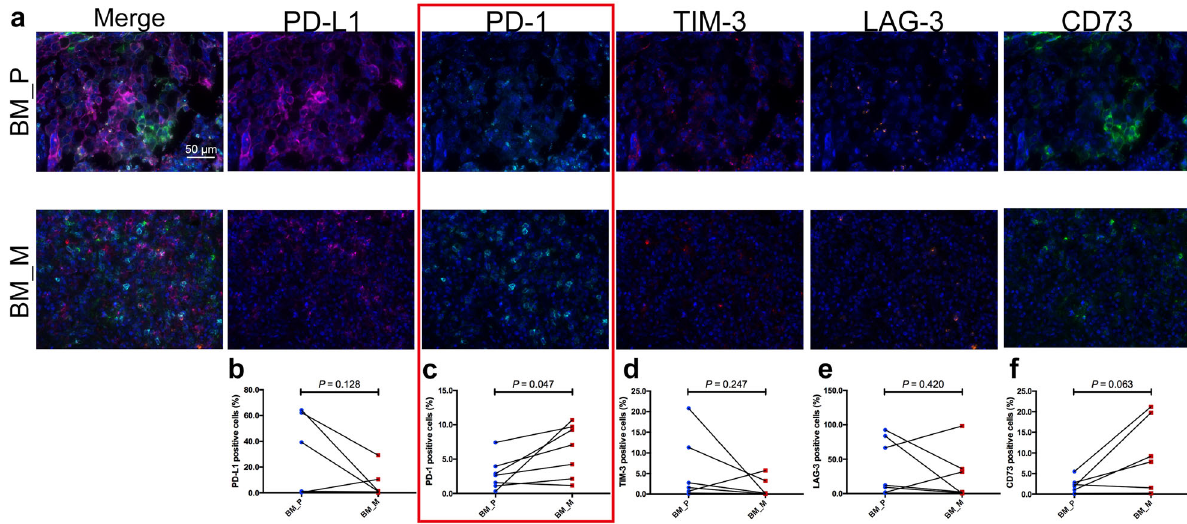
Fig. 6 Five immune checkpoints expression heterogeneity in tumor stroma of primary lesions and BM. a Representative images of MIF of immune checkpoints expression including PD-1, PD-L1, TIM-3, LAG-3, and CD73. MFI comparison of PD-L1 ( b ), PD-1 ( c ), LAG-3 ( d ), TIM-3 ( e ), and CD73 ( f ) cells between primaries and BM. MFI mean fl uorescence